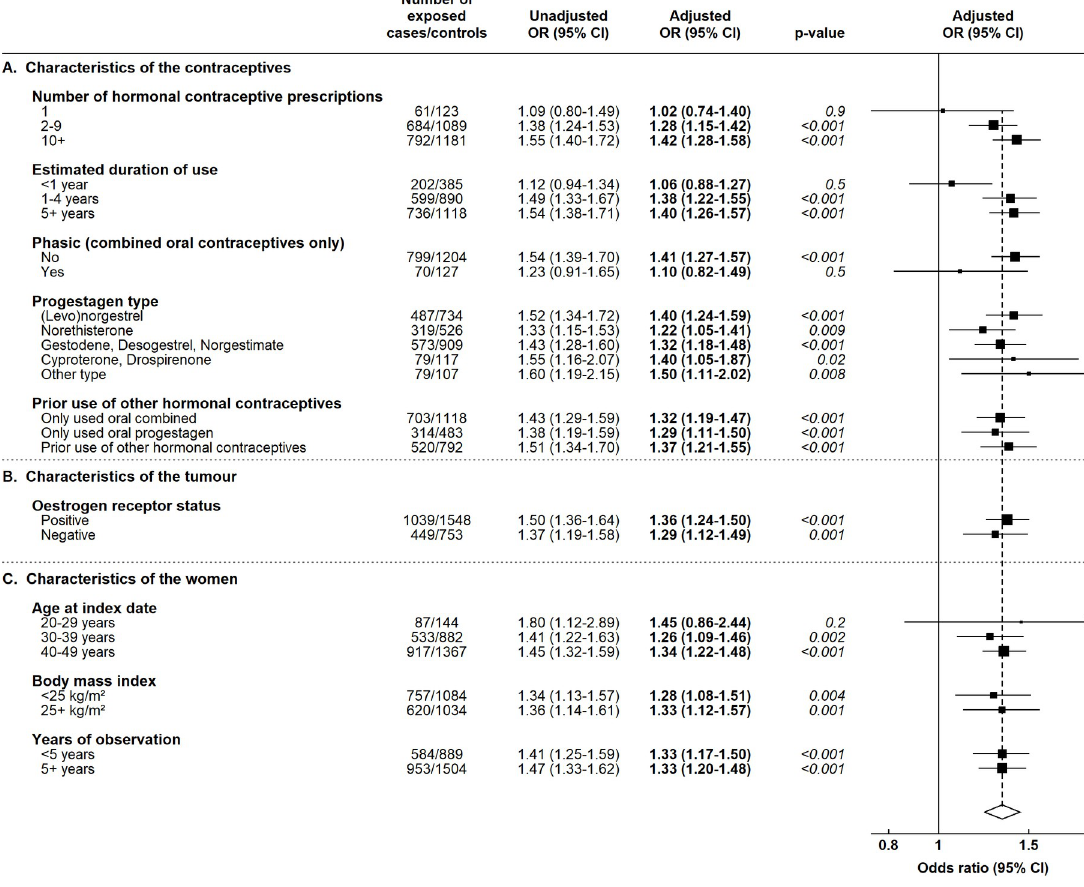
Fig 3. ORs and 95% CIs for breast cancer among current users of oral contraceptives versus women with no hormonal contraceptive prescriptions, across subgroups defined by characteristics of the oral contraceptives, breast tumour, or women. Data from the CPRD. Adjusted ORs are adjusted for time since last birth, number of recorded births, BMI, and alcohol intake. P values are based on the relevant Wald tests. BMI, body mass index; CI, confidence interval; CPRD, Clinical Practice Research Datalink; OR, odds